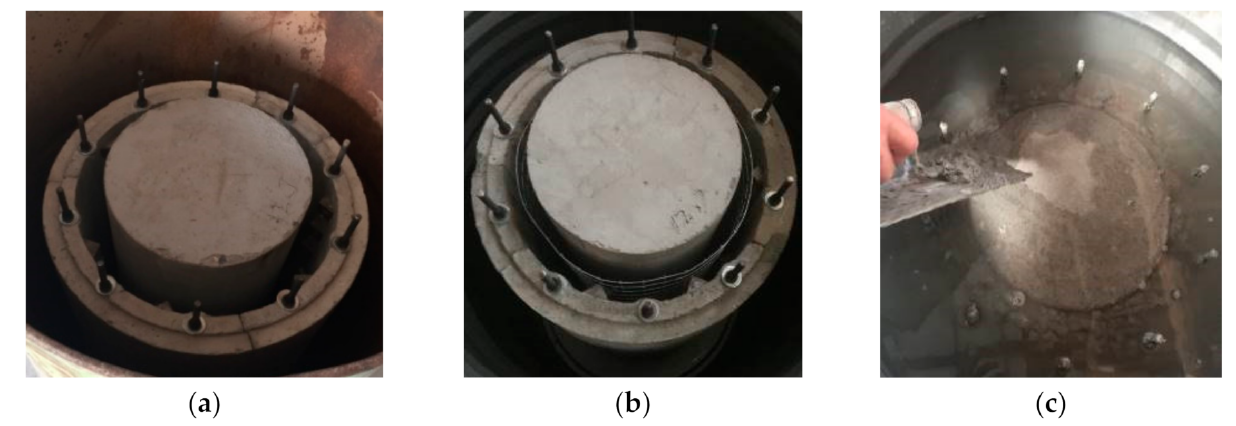
Figure 6. The production process for the strengthened specimens. ( a ) Preparing columns and LCSS; ( b ) Laying welded wire fabric; ( c ) Pouring